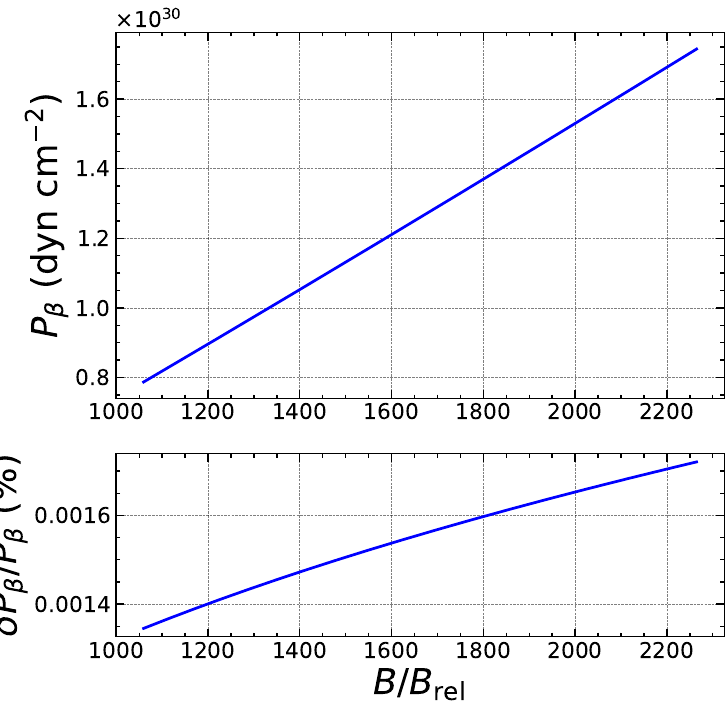
Figure 12. Same as Figure 11 in the strongly quantizing regime.